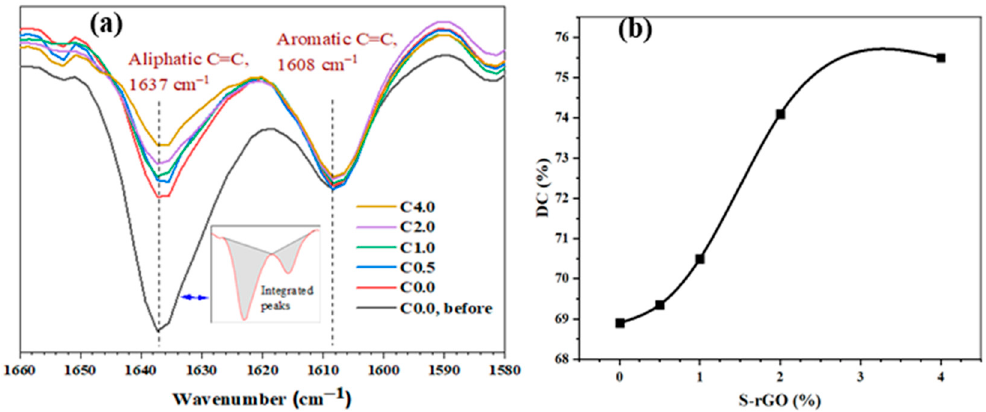
Figure 6. Representation of the double bond conversion for various SrGO-containing samples before (G0, before) and after curing (G0–G4) ( a ) characteristic FTIR spectra with peak area illustration ( b ) Obtained degree of conversion.